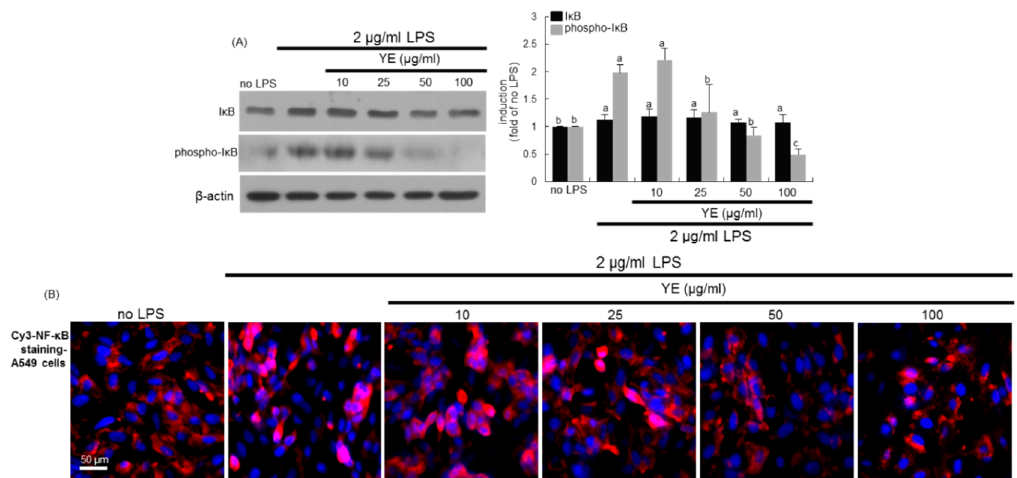
Figure 8. Involvement of NF- κ B signaling in lipopolysaccharide (LPS)-induced alveolar inflammation and blockade by dried yeast extracts (YE). Alveolar epithelial cells were incubated in media containing 2 µg/mL LPS in the absence and presence of 10–100 µg/mL YE for up to 24 h. Cell lysates were prepared for Western blot analysis with a primary antibody against I κ B and phospho-I κ B ( A ). β -Actin protein was used as an internal control. The bar graphs (mean ± SEM, n = 3) represent quantitative results of the left bands obtained from a densitometer. Values in respective bar graphs not sharing a same small letter indicate a significant difference at P < 0.05. Immunocytofluorescence analysis was done in LPS-treated A549 alveolar epithelial cells ( B ). The NF- κ B localization was identified as Cy3-red staining in cells exposed to LPS. Nuclear staining was done with DAPI (blue). Each photograph is representative of stained cells ( n = 4). Scale bar = 50 µm.